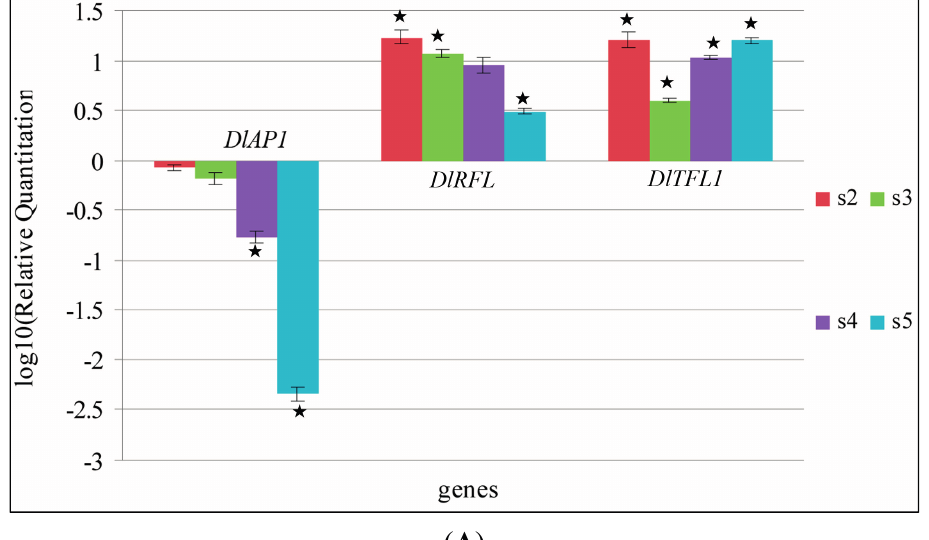
Figure 4. Ten candidate gene expression patterns in different stages in Dendrocalamus latiflorus (mean ± standard error; n ≥ 3). Stage 2 (S2), initiation of inflorescence; Stage 3 (S3), initiation of floral primordia; Stage 4 (S4), initiation of the primordia of stamen and pistil; Stage 5 (S5), the advanced floral primordium into a complete flower. ( A ) DlAP1 , DlRFL and DlTFL1 ; ( B ) DlFCA , DlID1 , and DlFT ; ( C ) DlMADS1 , DlMADS2 , DlSPL9 and DlEMF2 . Expressions of genes in stages 2, 3, 4, and 5 were compared to stage 1. The data presented are the means of three technical